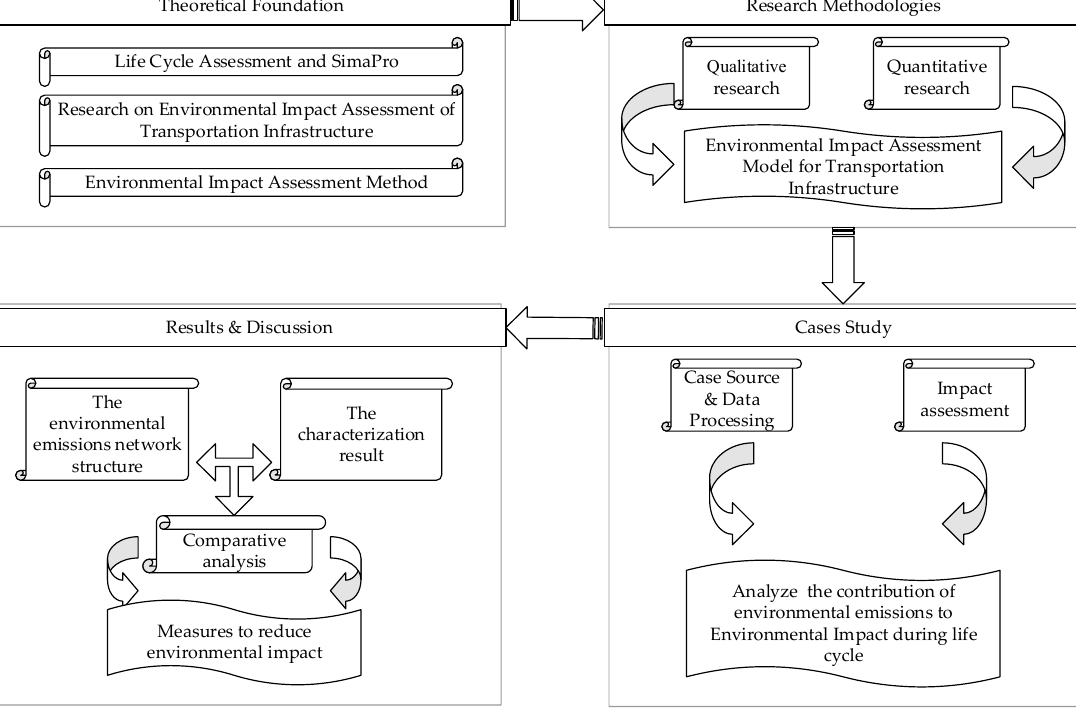
Figure 1 . Framework of the research methodology. Figure 1. Framework of the research